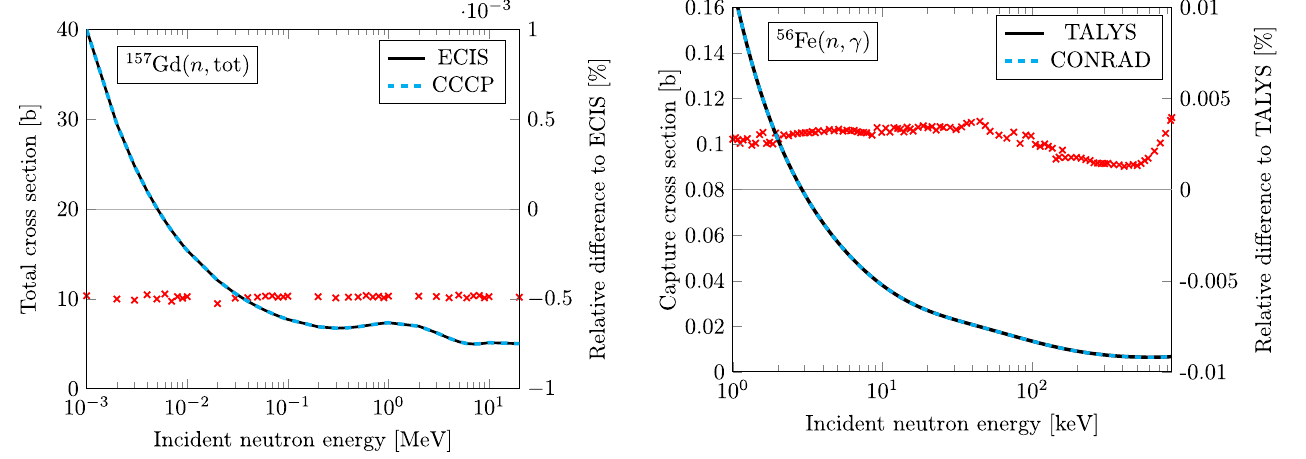
Fig. 6. ECIS06/CONRAD (aka CCCP) total cross section comparisons on 157 Gd.